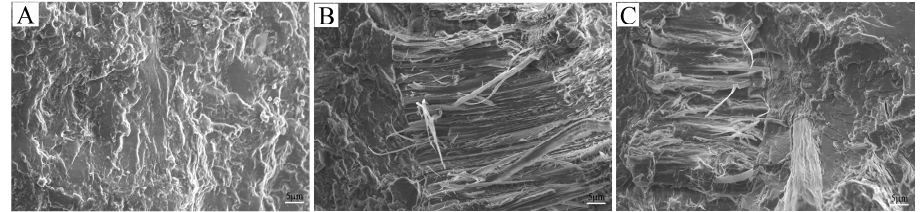
Figure 4. Cross-sectional scanning electron microscopy photographs of the adhesive: ( A ) MSM adhesive, ( B ) MSM/NCC adhesive, and ( C ) MSM/MNCC adhesive. adhesive, ( B ) MSM/NCC adhesive, and ( C ) MSM/MNCC